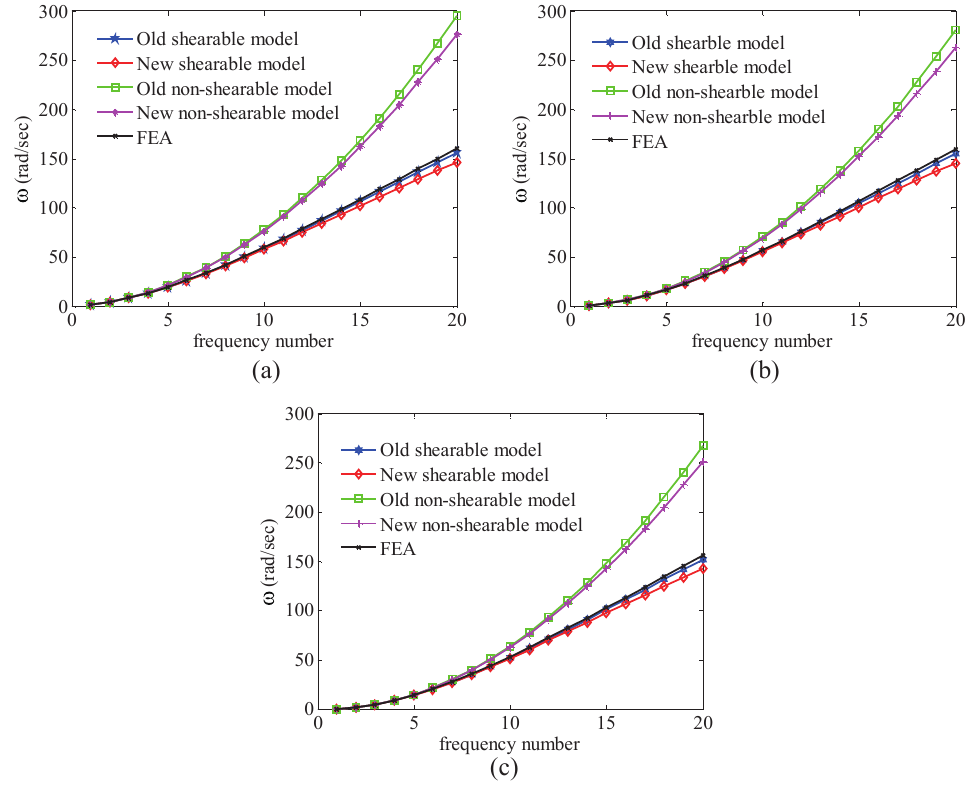
Fig. 3. Bending natural frequencies for a 300 m lattice structure for a) clamped-clamped b) simply supported c) free-free boundary condition.